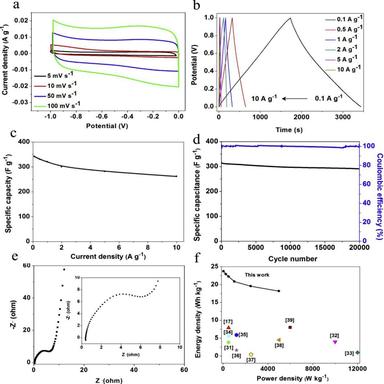
CV curves of CDC at different scan rates (a), GCD curves (b) and specific capacitance (c) of CDC at different current densities, cycling stability and coulombic efficiency of CDC at 1 A g1 (d), Nyquist plots (e) and Ragone plot (f) of CDC.